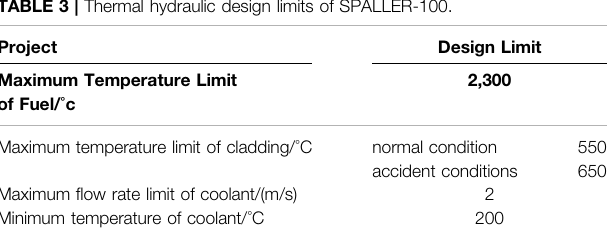
TABLE 3 | Thermal hydraulic design limits of SPALLER-100.